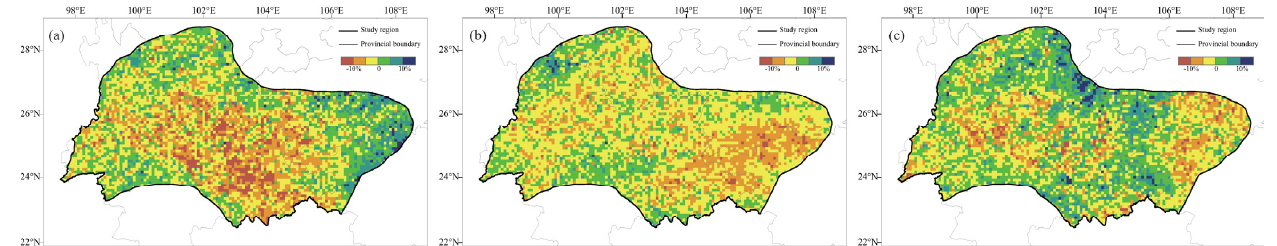
Figure 6. The spatial distributions of annual NDVI anomaly percentage in 2010 ( a ), 1999 ( b ), and 2013 ( c ) relative to the average for the period 2000–2009.